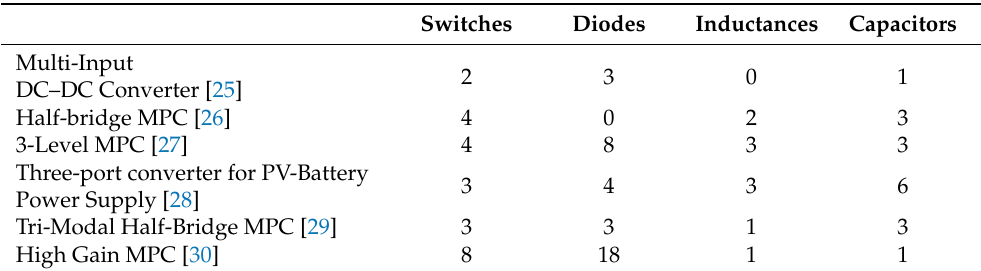
Table 1. Component specifications for several types of MPCs.